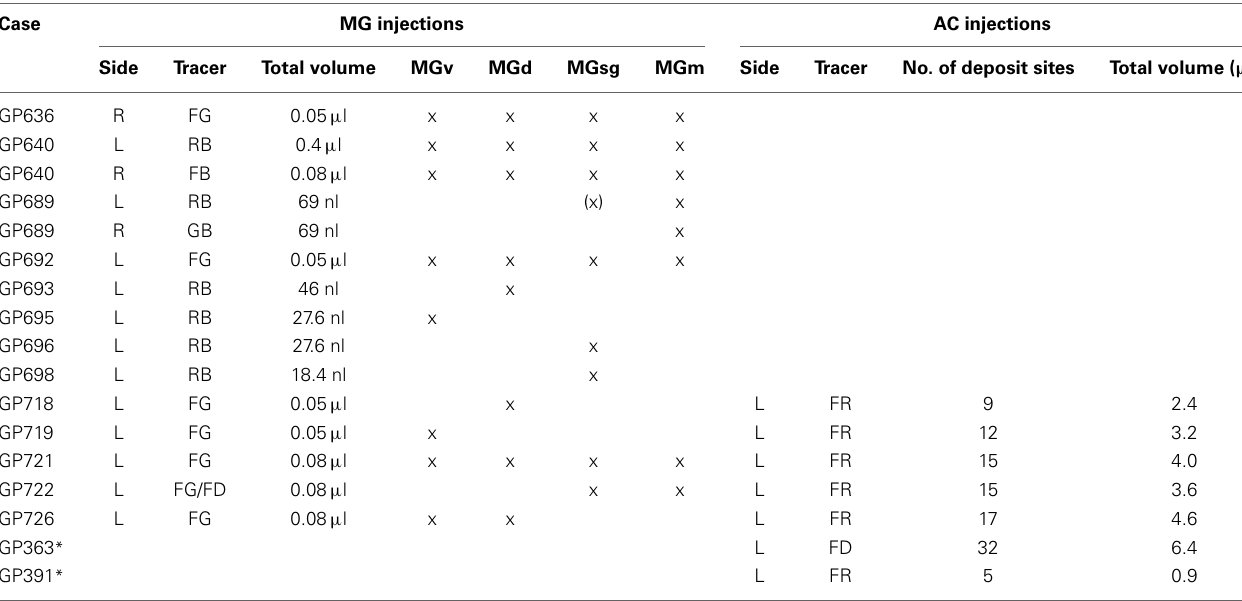
Table 1 | Injections into the MG or